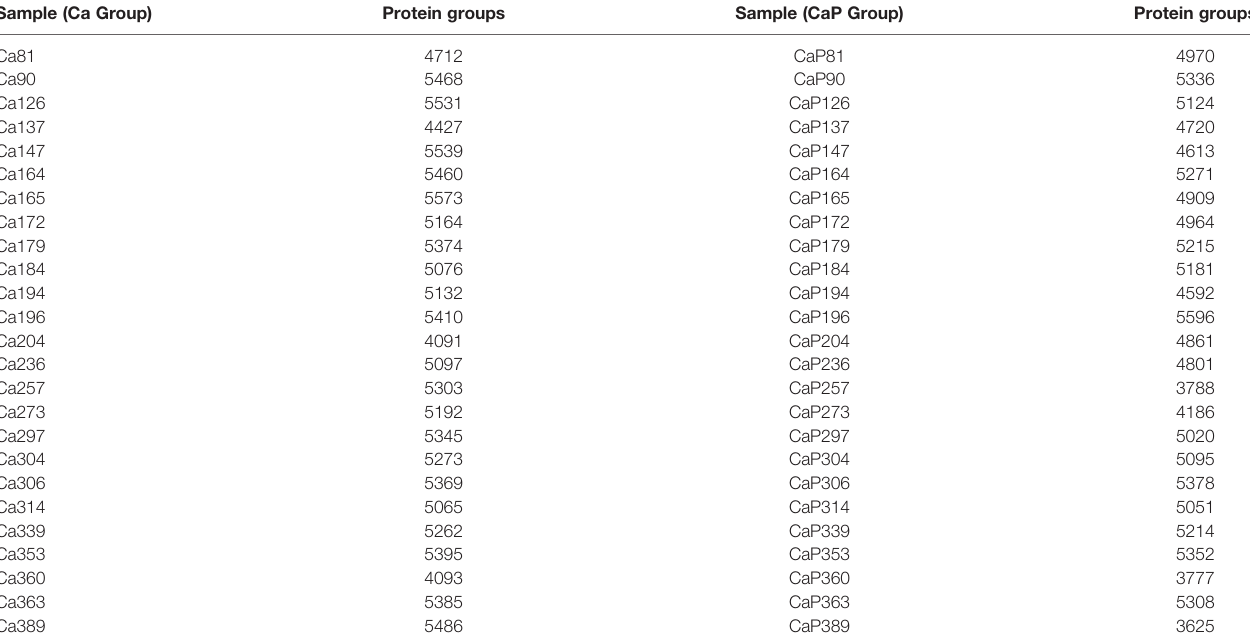
TABLE 2 | DIA protein identi fi cation results statistics. Sample (Ca